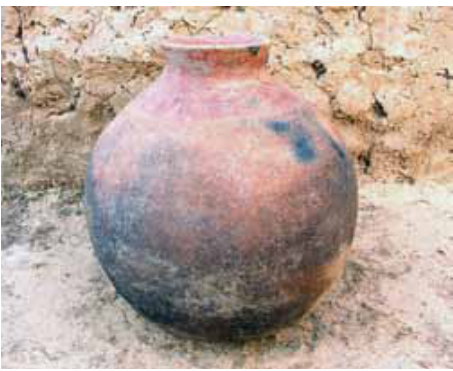
Fig. 7: A jar with braided strip roulette from the abandonment layer of Unit